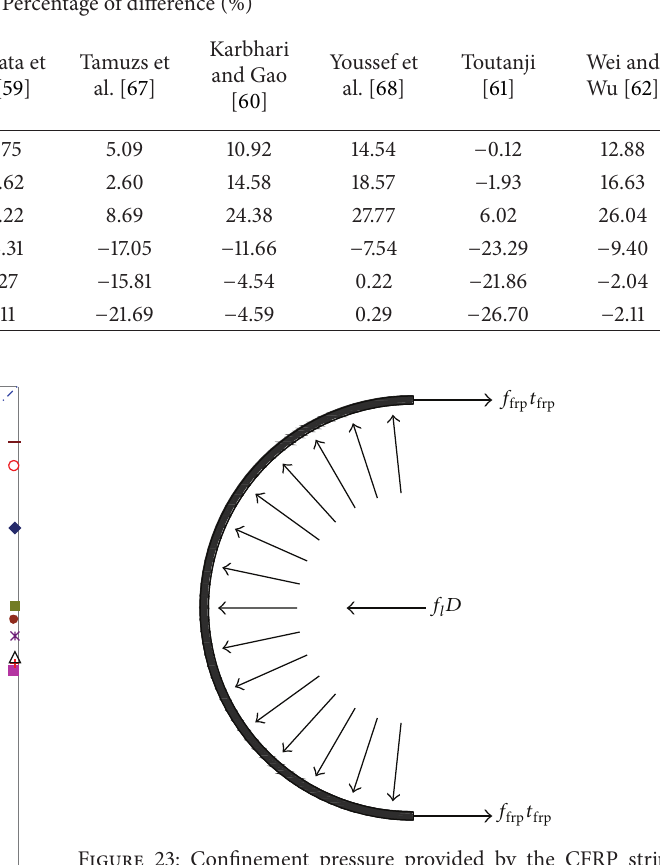
Figure 23: Confinement pressure provided by the CFRP strips CFRP